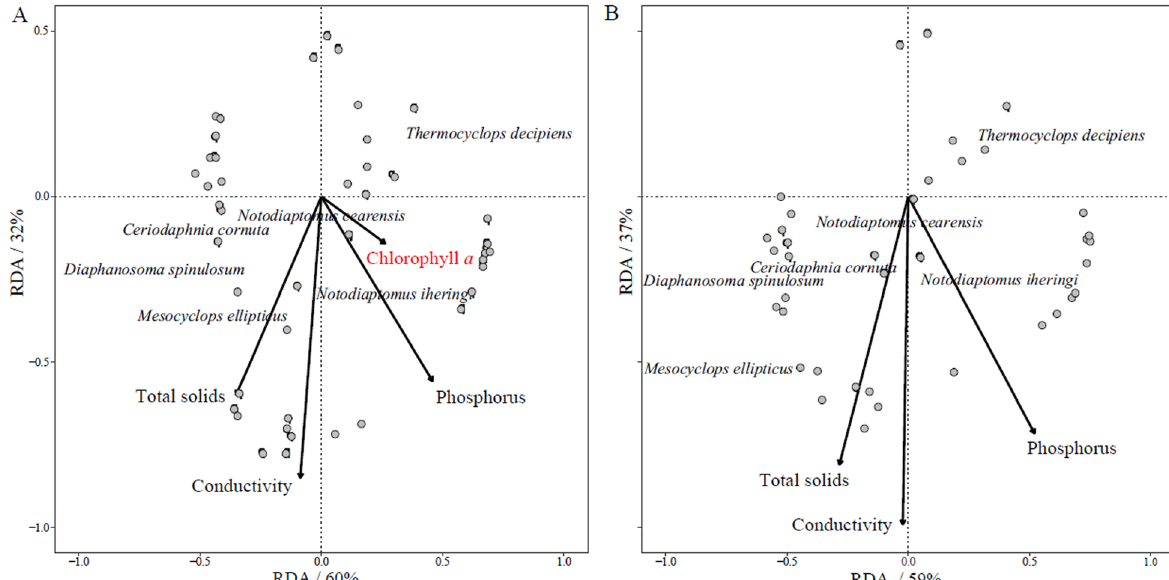
Figure 5. Redundancy Analysis (RDA) of microcrustaceans (Cladocera and Copepoda) and environmental descriptors that were significant in the analysis considering formalin-preserved abundance (a) and corrected abundance values (b) in three reservoirs in neotropical semiarid ecosystems (Pernambuco, Brazil). In red, we highlight the variable that was selected only in the formalin-preserved abundance (traditional studies of formaldehyde). The arrows indicate the influence vectors of each explanatory